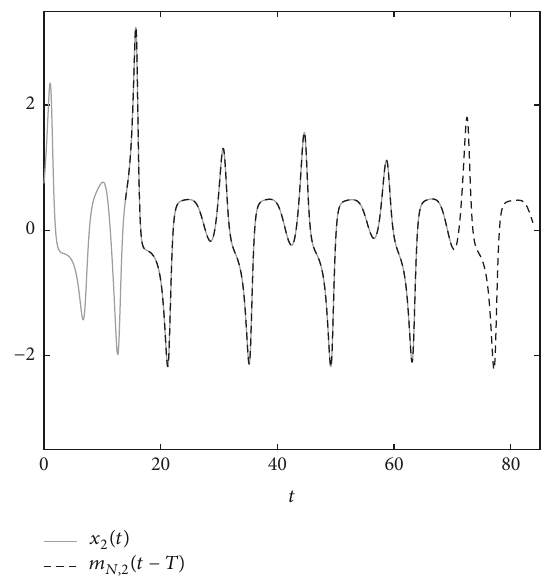
𝑢 : R + × R 2 → R 2 is defined with the same dimension of